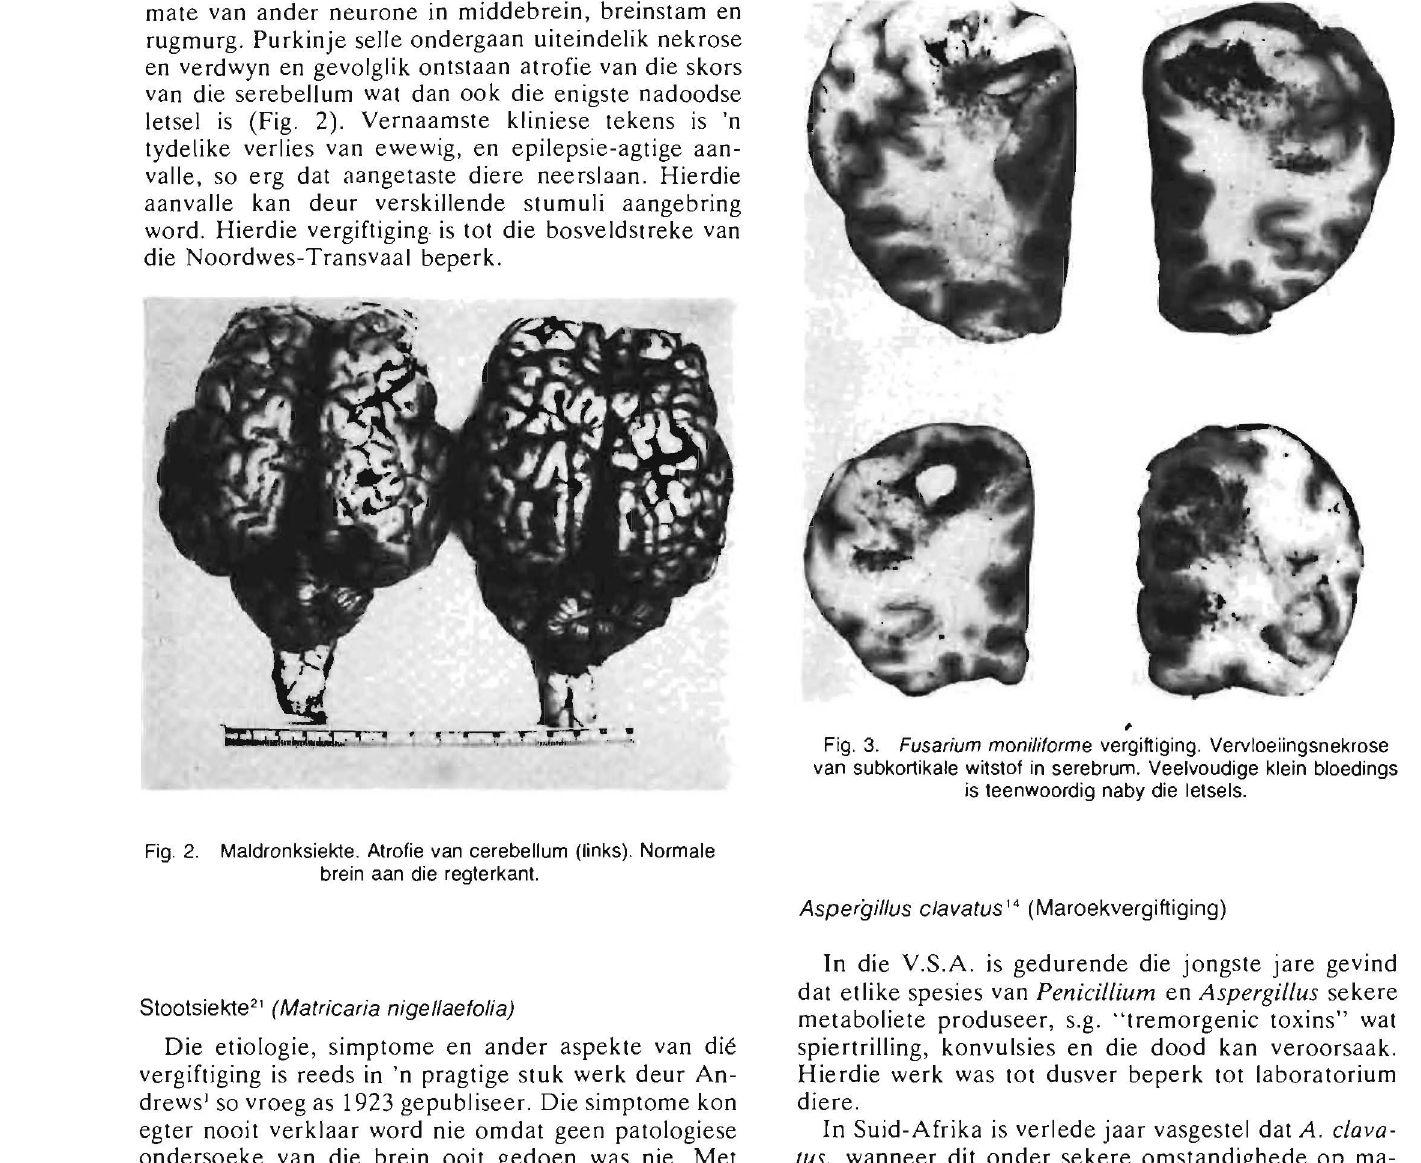
Aspergillus ciavatus 14 (Maroekvergiftiging)